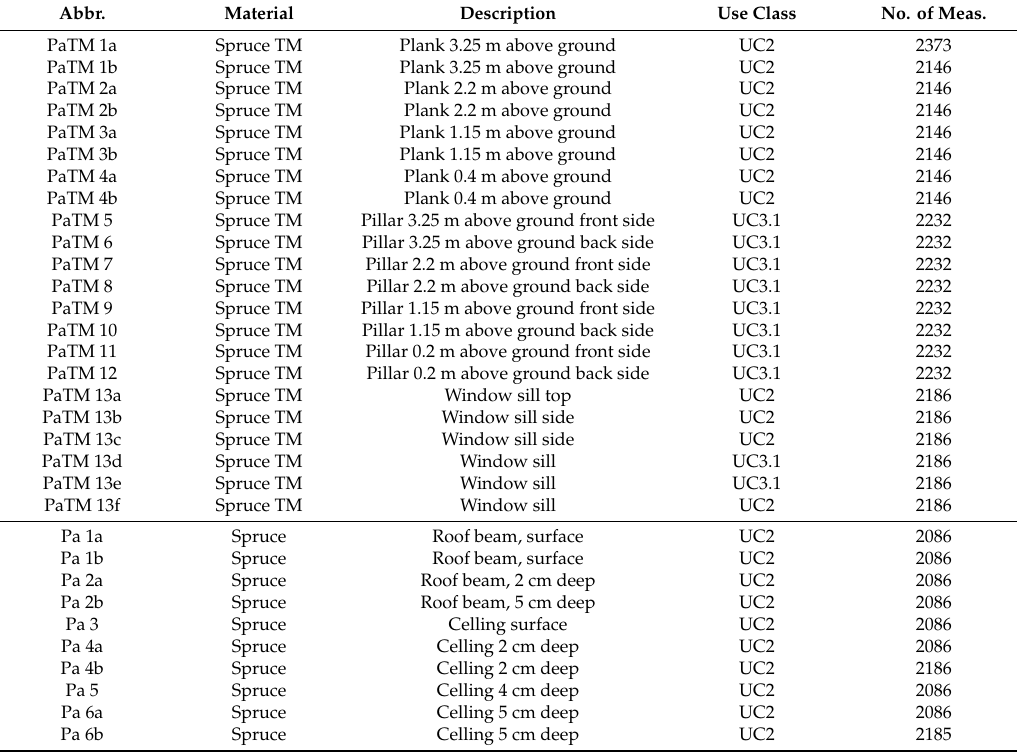
Table 1. Descriptions of the moisture content monitoring locations on the façade of the Annex of the Wood Science and Technology building in Ljubljana. Use classes are defined according to EN 335 [14].